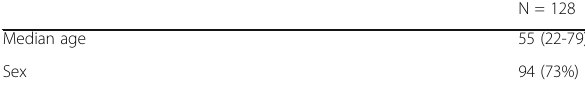
Table 1 (abstract 0364). Demographic characteristics